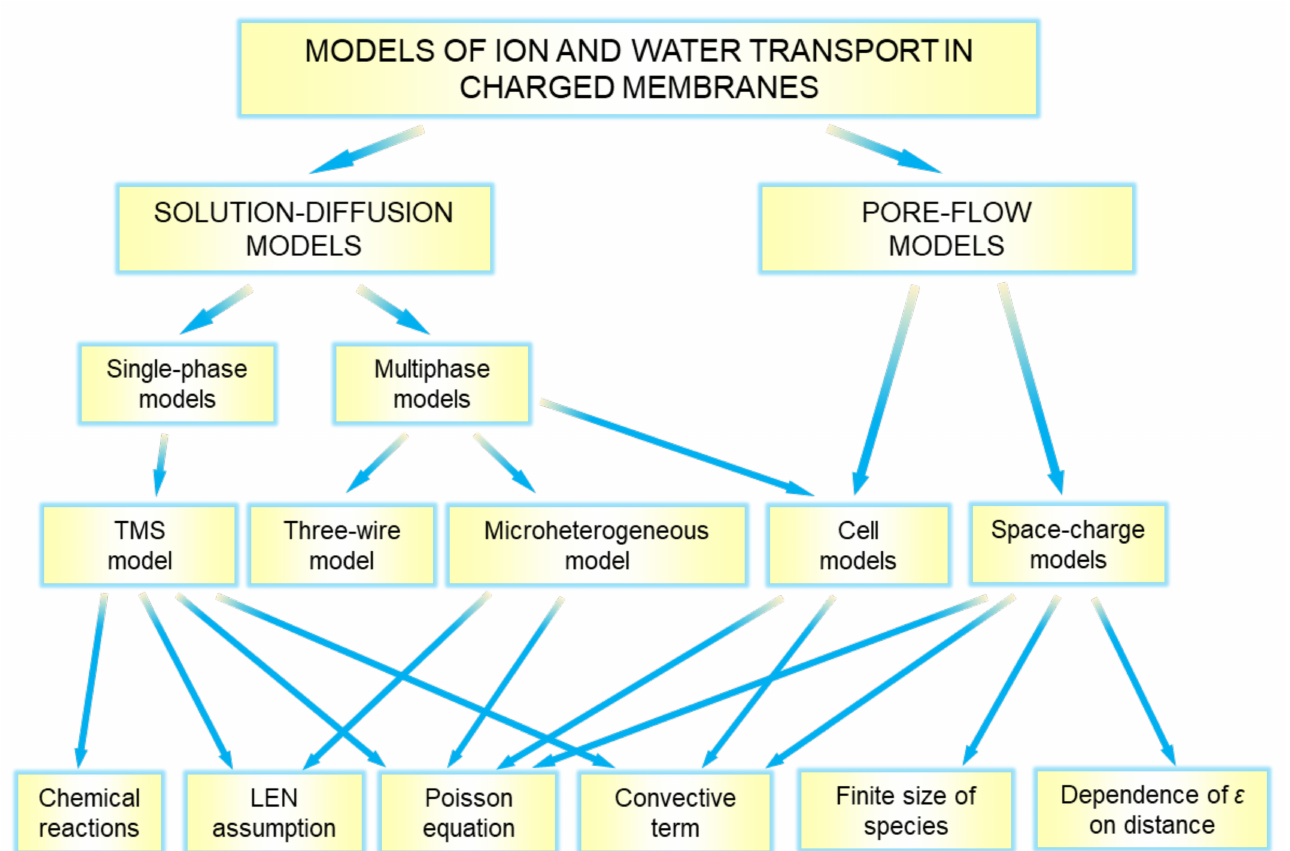
Figure 10. Classification of mathematical models used for describing ion and water transport in charged